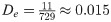
Schematic illustration of local edge density (De), showing a case with high De and one with low De.In this figure, voxels are depicted as small spheres. The value of De of the (thick red) edge connecting the two red voxels in the centre is computed as follows: First, we consider the 26-adjacent neighbours of its endpoints (shown here as grey and green spheres). Theoretically, the highest possible number of edges connecting any two endpoint voxels across the 26-neighbourhoods is 27 × 27 = 729. We define the local edge density De as the number of edges whose z-values are above a user-defined threshold zt divided by the total number of possible edges (i.e. 729). In the above examples, lines connecting nodes (voxels) indicate supra-threshold edges. In example (A), 11 out of 729 possible edges are above threshold, thus De=11729≈0.015. In example (B), only 5 out of 729 possible edges are above threshold, thus, De=5729≈0.007.